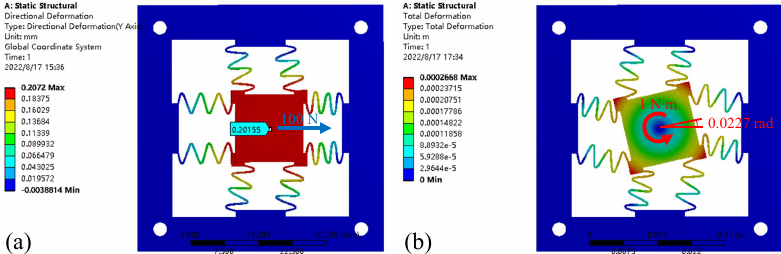
Figure 6. Simulated deformation of the platform: ( a ) axial deformation when subjected to an axial force of 100 N, and ( b ) rotation when subjected to a torque around the z -axis of 1 N · m.